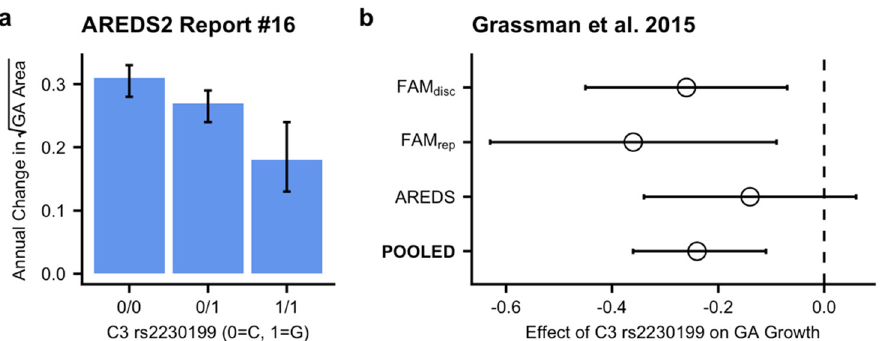
Figure 4. Decreased geographic atrophy (GA) progression with C3 risk allele. ( a ) Annual change in square root-transformed GA area stratified by presence of risk-conferring C3 alleles as reported in AREDS2 Report #16 [41]. ( b ) Meta-analyzed effect of C3 rs2230199 risk allele on GA growth from Fundus Autofluorescence in Age-Related Macular Degeneration (FAM study; disc: discovery cohort; rep: replication cohort) and Age-Related Eye Disease Study (AREDS) with the vertical dashed line showing the null result of no statistically significant effect. ( a , b ) Error bars indicate 95% confidence intervals.